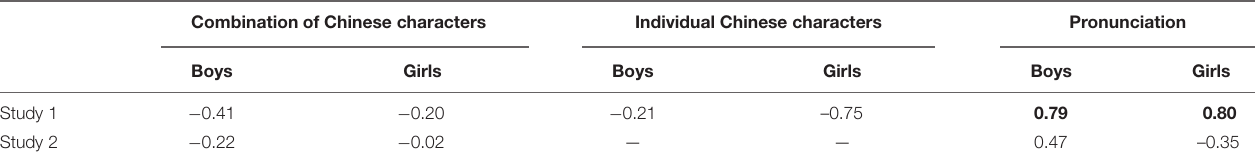
TABLE 4 | Correlation coefficients between each index of name and Japanese Collectivism Scale (JCS; Yamawaki, 2012) in Study 1 and